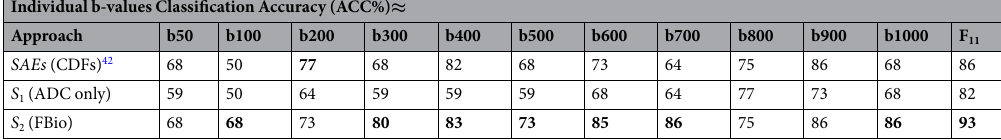
Table 3. Comparison of the approximated percentage diagnostic accuracy (ACC%) obtained at individual and fused b-values (F 11 ) between the first scenario ( S 1 ) using the ADC maps alone with the CNN-based classification system, the second scenario ( S 2 ) utilizing the fusion of the clinical biomarkers and the image markers using the same CNN-based classification system, and the classification using the CDFs of the ADCs obtained from the segmented kidney based upon use of stacked auto-encoders (SAEs) 42 .